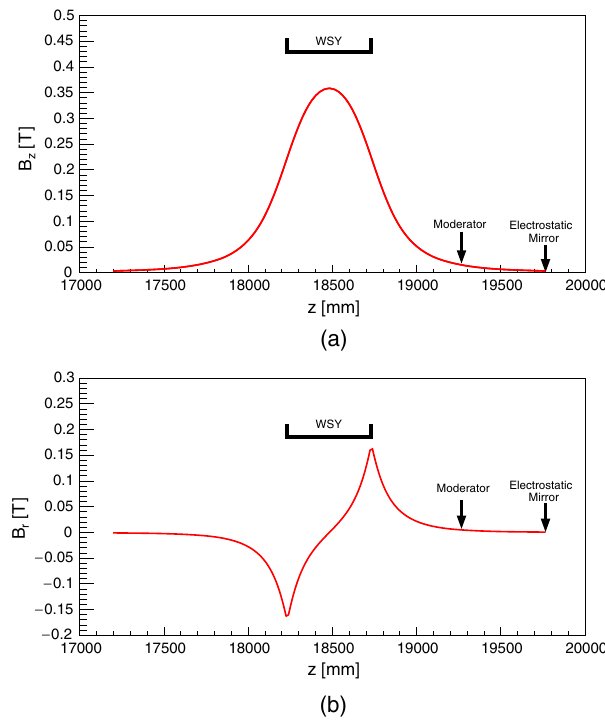
FIG. 6. The magnetic field of the solenoid used in G4beamline: (a) B z component along the center line; (b) B r component at maximum aperture r ¼ 20 cm. The field has been tuned to get the maximum intensity on moderator. The horizontal axis shows the position in the beamline. The center of the solenoid WSY is located at z ¼ 18 ; 481 mm and moderator is located at z ¼ 19 ; 266 mm.